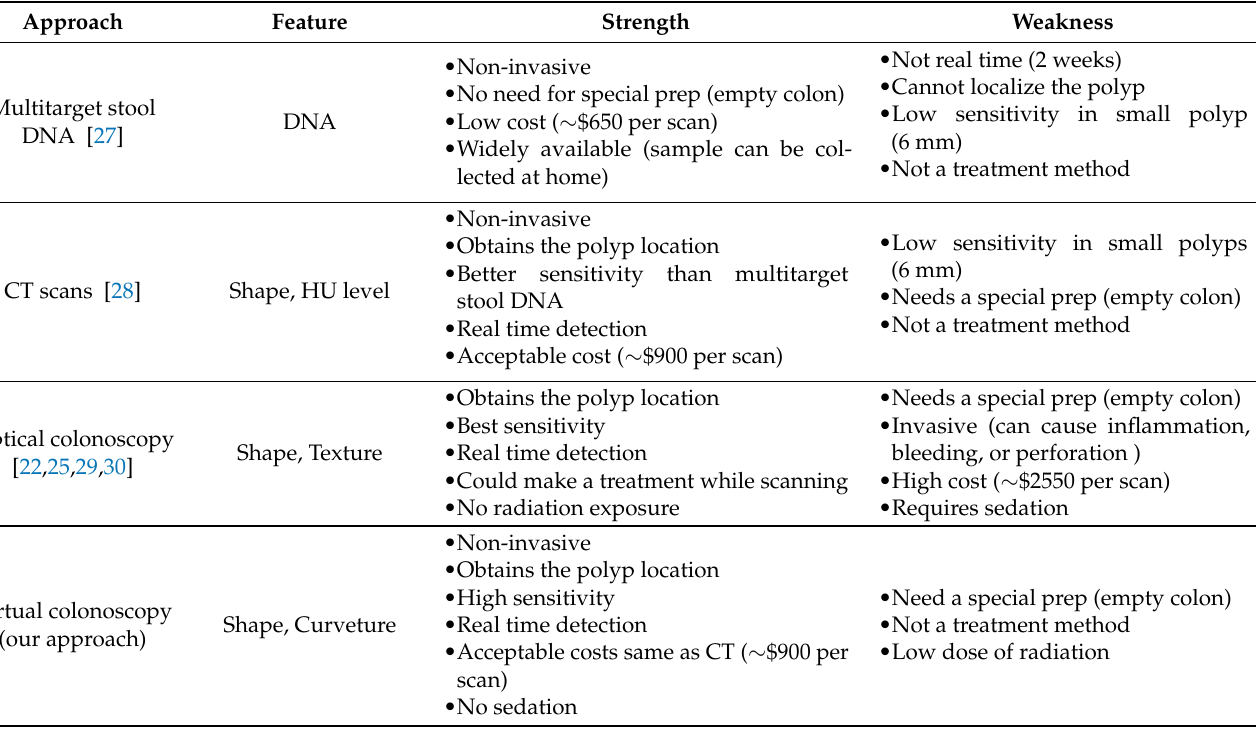
Table 1. Polyp detection approaches comparison.